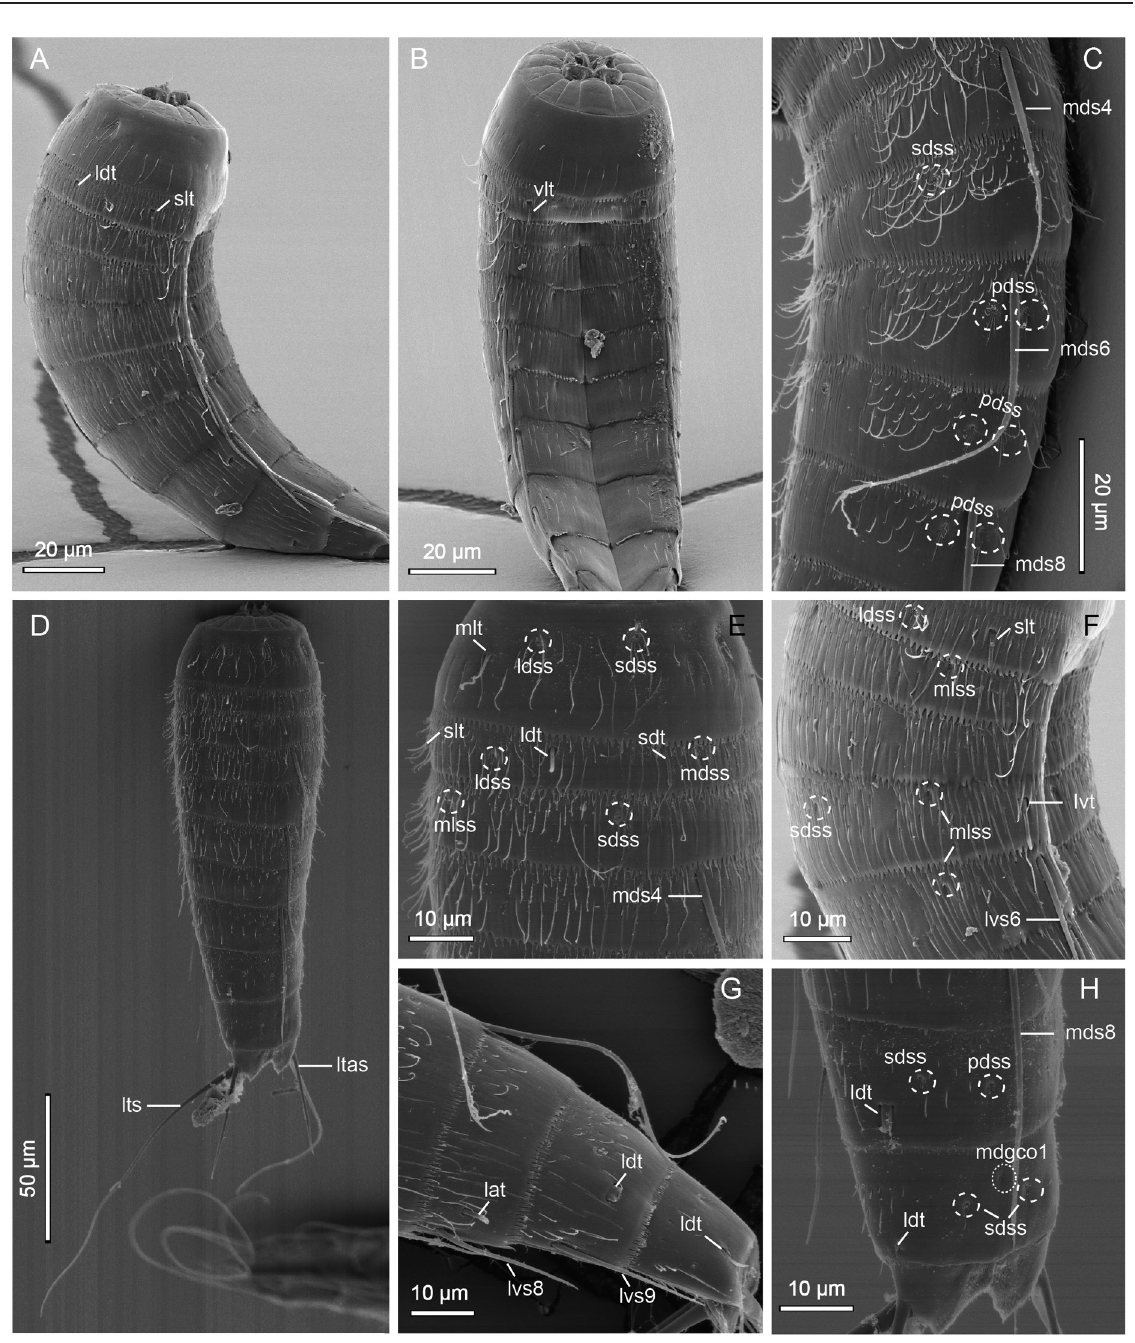
Fig. 19. Scanning electron micrographs showing overviews and details of Echinoderes frodoi sp. nov. A . Lateral overview. B . Ventral overview. C . Segments 4 to 8, laterodorsal view. D . Dorsal overview. E . Segments 1 to 4, laterodorsal view. F . Segments 2 to 6, lateral view. G . Segments 8 to 10 of male, lateral view. H . Segments 9 to 11 of female, laterodorsal view. Abbreviations: see Material